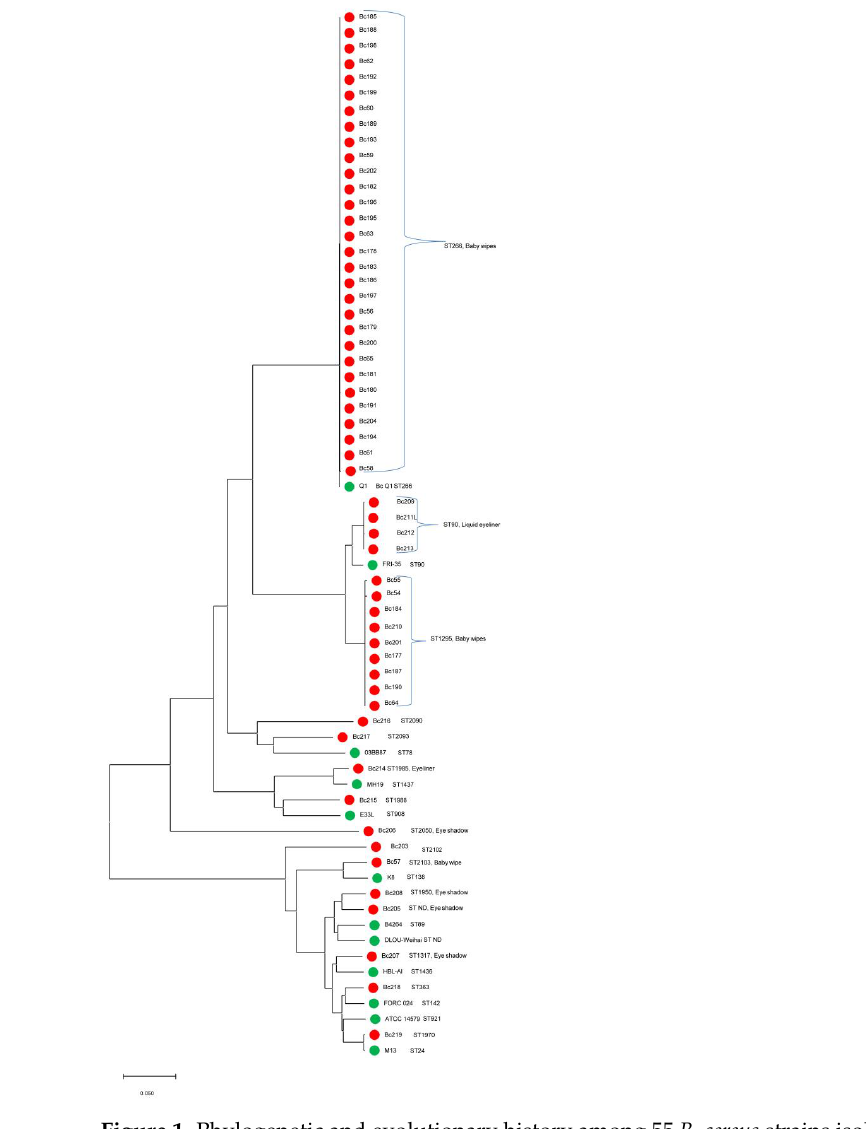
Figure 1. Phylogenetic and evolutionary history among 55 B. cereus strains isolated from baby